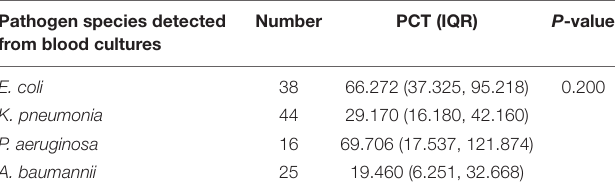
TABLE 2 | PCT values associated with different